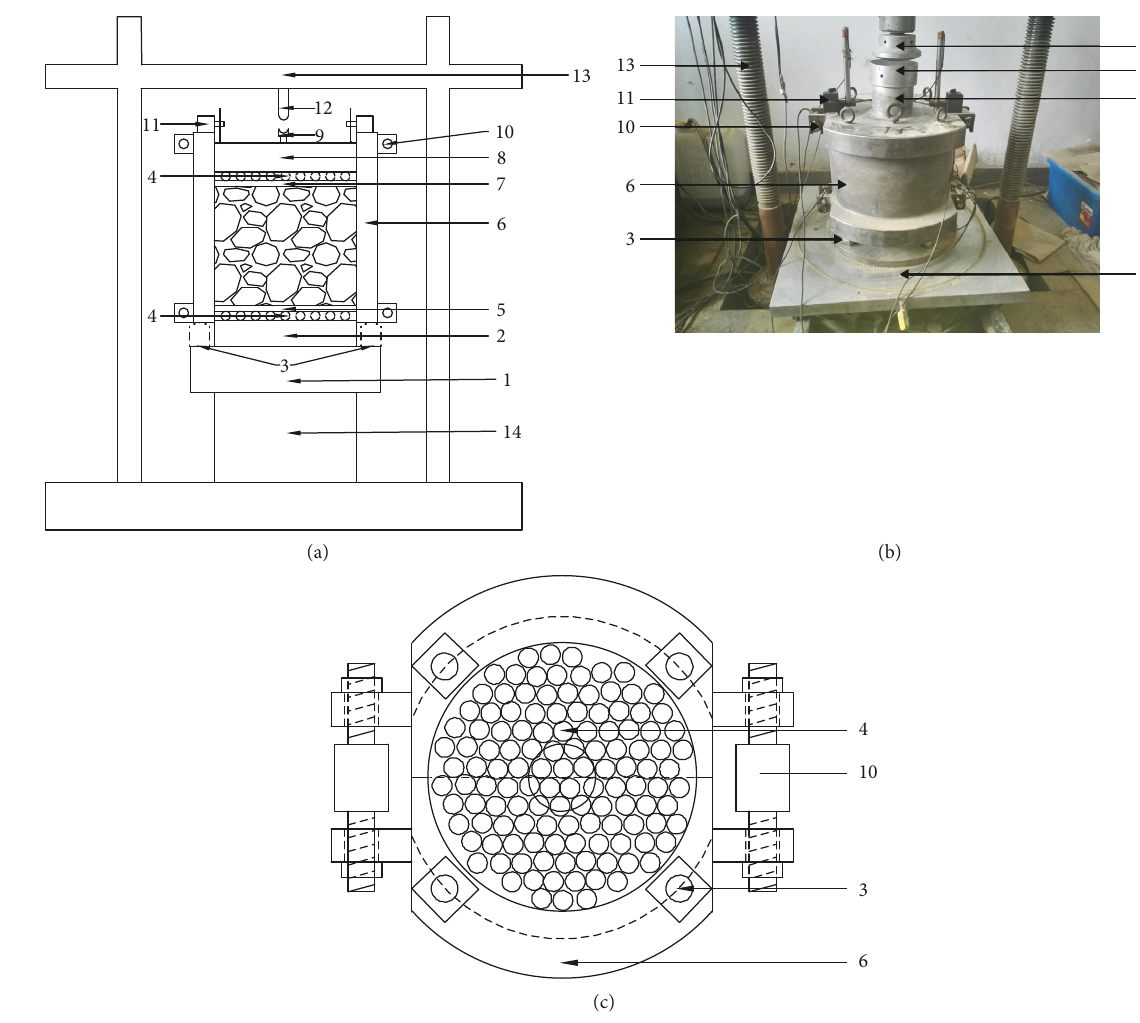
Figure 1: Sketch map of test equipment. (a) Sketch map of the apparatus. (b) Photo of the apparatus. (c) Top view of the apparatus ( 1, base; 2, baseplate; 3, load sensor; 4, steel ball; 5, the bottom force transmission plate; 6, semicircle rigid cylinders; 7, the top force transmission plate; 8, pressure plate; 9, compression plate; 10, pull pressure sensor; 11, displacement sensor; 12, load sensor; 13, loading frame; 14, load